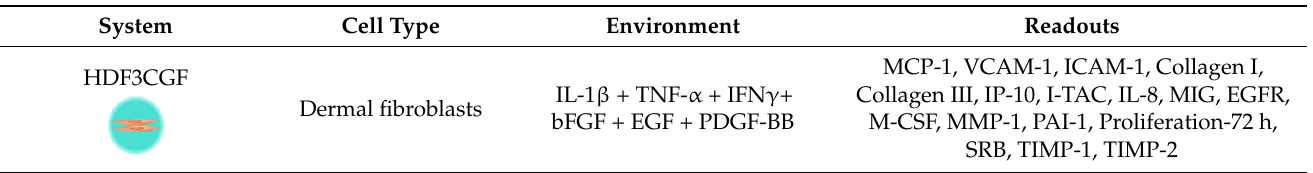
Figure 2. The effect of CGA on collagen secretion in HDF- α cells. ( A ) The soluble total collagen content in the supernatant of HDF- α cells were measured after exposure of CGA for 48 h. ( B ) The cell viability inhibition of HDF- α cells treated with CGA for 24, 48 , or 72 h were detected by MTT assay. The values are expressed as the mean ± SD. from three experiments. ** p ≤ 0.01, *** p ≤ 0.001 indicate a significant